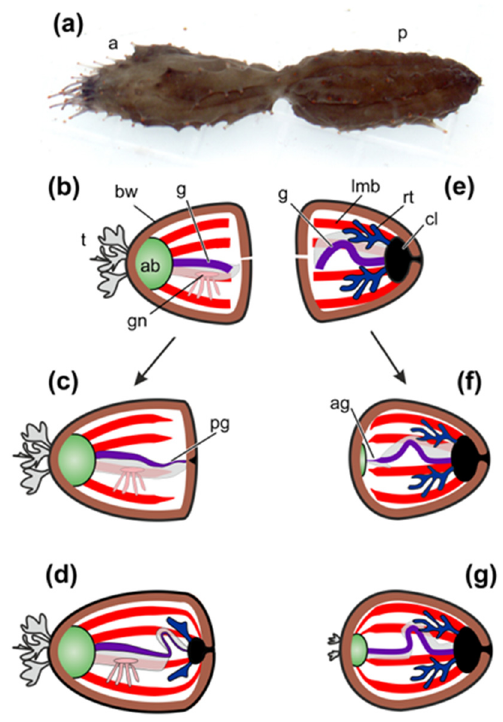
Figure 1. Scheme of regeneration of internal organs after fission in Cladolabes schmeltzii . ( a ) C. schmeltzii during fission. ( b ) Anterior fragment just after fission. ( c ) Formation of gut and cloaca in anterior fragment. ( d ) Formation of respiratory trees in anterior fragment. ( e ) Posterior fragment just after fission. ( f ) Formation of aquapharyngeal bulb (AB) and gut anlage in posterior fragment. ( g ) Posterior fragment with regenerated internal organs. a, anterior part; ab, aquapharyngeal bulb; ag, anterior anlage of gut; bw, body wall; cl, cloaca; g, gut; gn, gonad; lmb, longitudinal muscle band; p, posterior part; pg, posterior anlage of gut; rt, respiratory tree; t, tentacles.